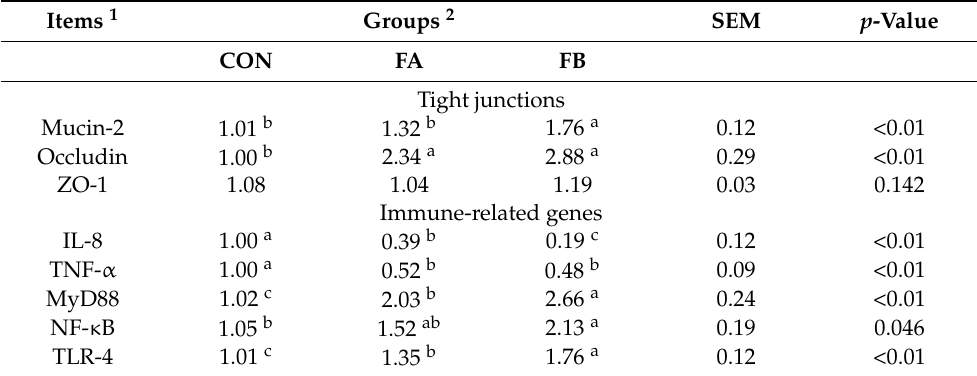
Table 5. Effects of fermented feed on the mRNA levels of genes in the jejunum of laying